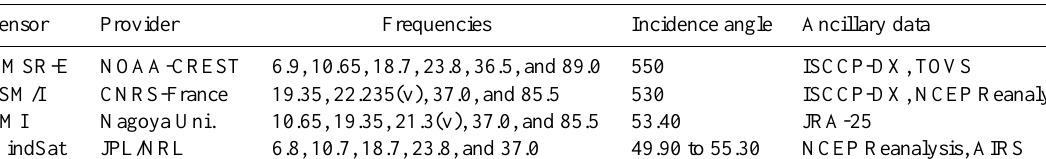
Table 1. List of global land surface emissivity products used in this study.